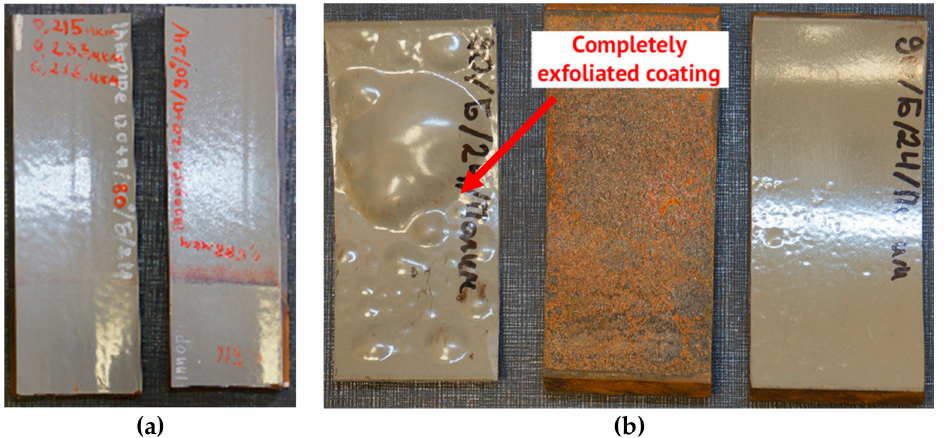
Figure 6. Samples of the same coating from different manufacturers of products after autoclave decompression tests: ( a ) samples from manufacturer 1; ( b ) samples from the manufacturer